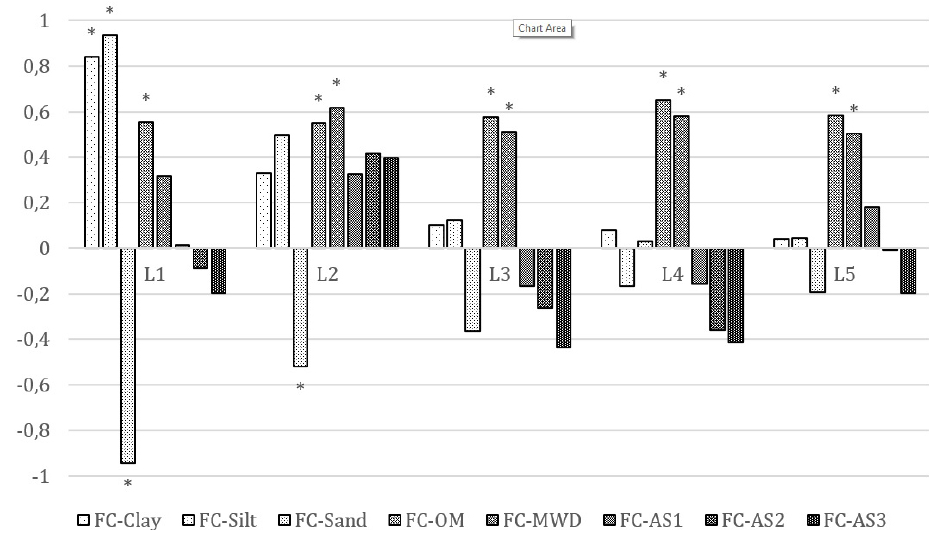
Figure 3. The correlation coefficients between field capacity and other soil properties in sampling areas (L1, L2, L3, L4 and L5 are the sampling sites; see Fig. 2). ∗ Significant relationship at α = 0.01.